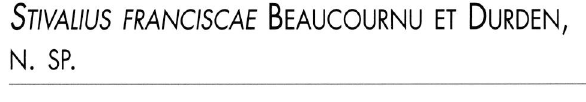
(fig. 10) relativement longue, réticulée, arrondie, se continuant en pente courbe par un lobe latéral hyalin finement déchiqueté. Sclerite de Ford allongé, voisin de celui de S. cognatus Jordan et Rothschild, 1922 et surtout de celui de S. exoticus. ment vers l'apex.